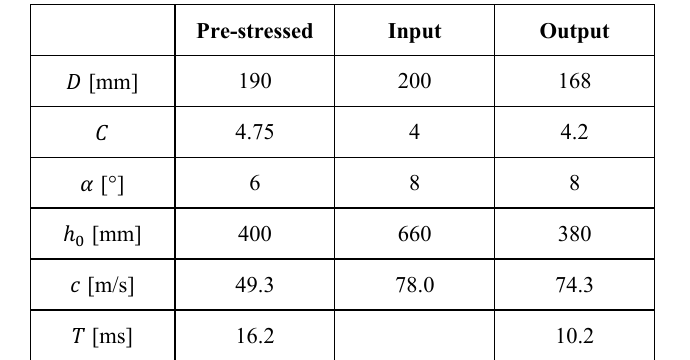
Table 1. Hopkinson Spring